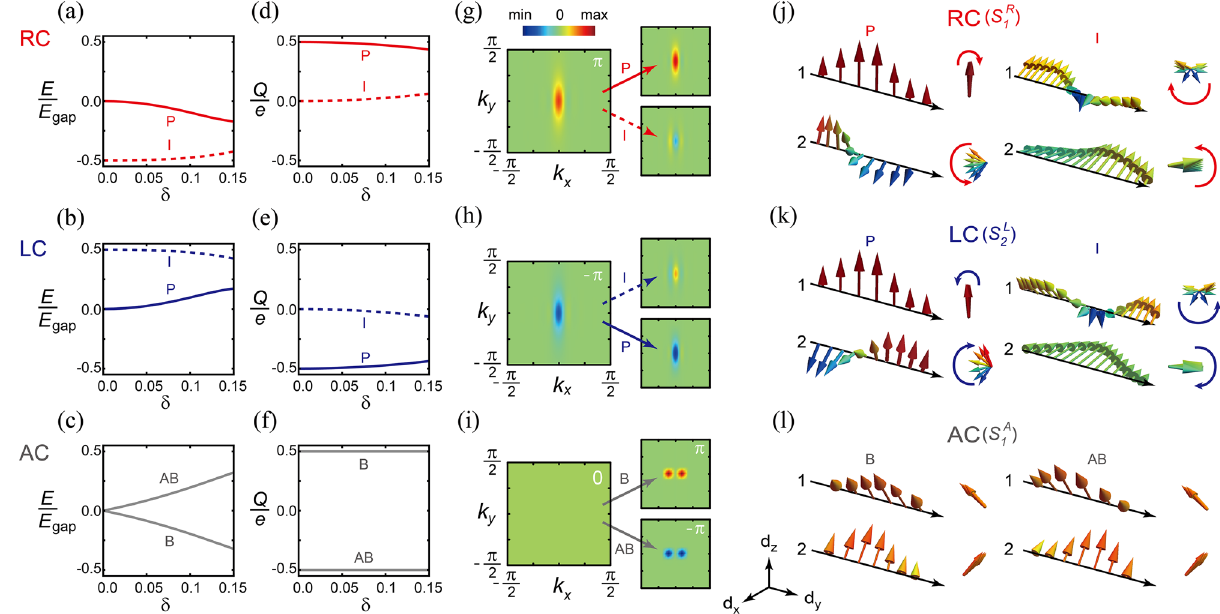
Figure 3. Fractionalized topological solitons and their PA dualities. ( a – c ) Spectra of fractionalized solitons with respect to the interchain coupling strength δ for RC-, LC-, and AC-solitons. In ( a ) and ( b ), the primary (P) and induced (I) subsoliton states are represented by solid and dashed lines, respectively. In ( c ), bonding (B) and antibonding (AB) subsoliton states are indicated by gray lines. The soliton spectra are normalized by the energy gap E gap for each δ . ( d – f ) Topological charges (or equivalently electron numbers) of subsolitons with respect to δ . Topological charges are normalized by the electron charge e . In each plot, the sum of topological charges of two subsolitons are the quantized: ( d ) e /2, ( e ) − e / 2 , and ( f ) 0. ( g – i ) Fractionalized Berry curvatures for ( g ) RC-, ( h ) LC-, and ( i ) AC-solitons ( δ = 0.1 ). The total Berry curvature (left) is divided into two fractionalized Berry curvatures (right). The integrated value is indicated at the upper right corner in each plot. ( j – l ) Spatially distributed pseudospin vectors for ( j ) RC-, ( k ) LC-, and ( l ) AC-subsolitons along each chain. Pseudospin vectors of primary (left diagram) and induced (right diagram) subsoliton states are plotted for ( j ) RC- and ( k ) LC-solitons. Compared with the RC-soliton, each pseudospin vector for the LC-soliton rotates oppositely due to PA duality. In ( l ), the pseudospin vectors of bonding states in one chain (left diagram) are related to those of antibonding states in the other chain (right diagram) by reversing x -component due to self PA duality (see Section S5 in Supplementary